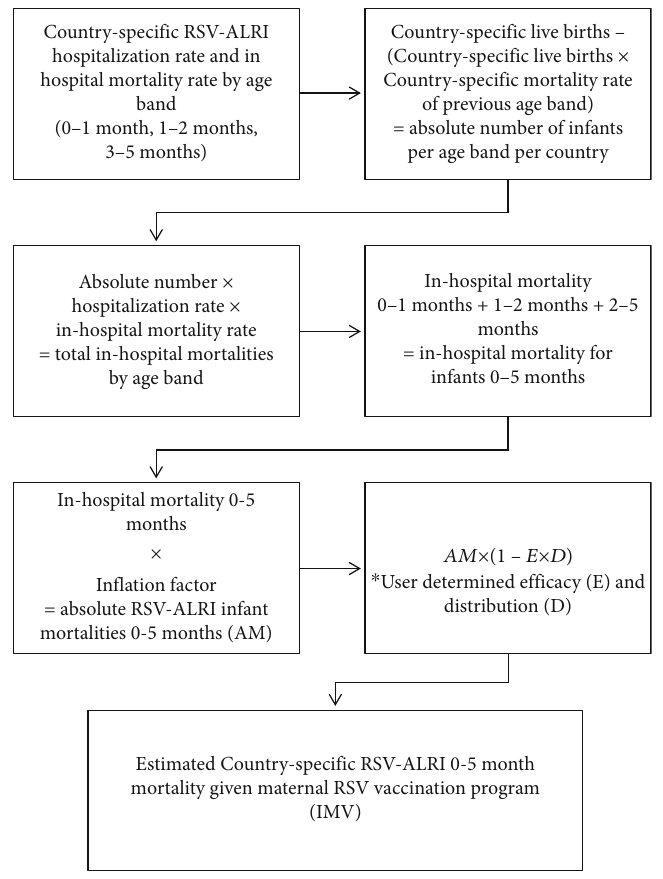
Figure 3: Flowchart of calculation of country-speci fi c infant (0-5 months) RSV